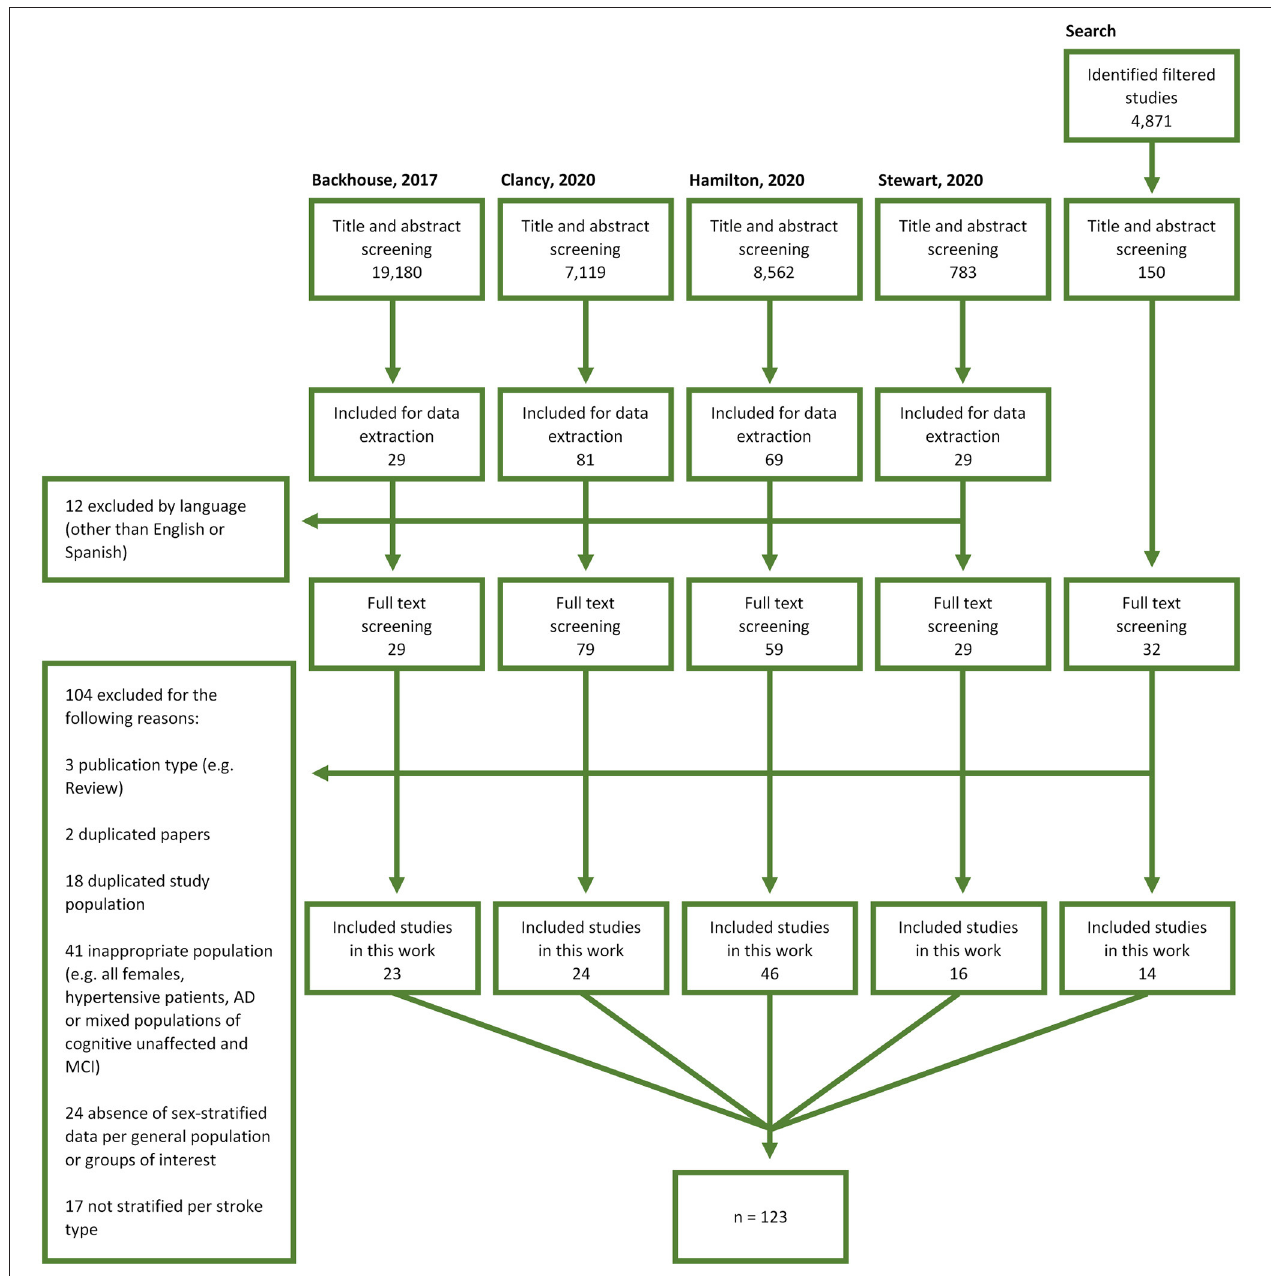
FIGURE 1 | Study selection flow diagram. AD, Alzheimer’s Disease; MCI, mild cognitive